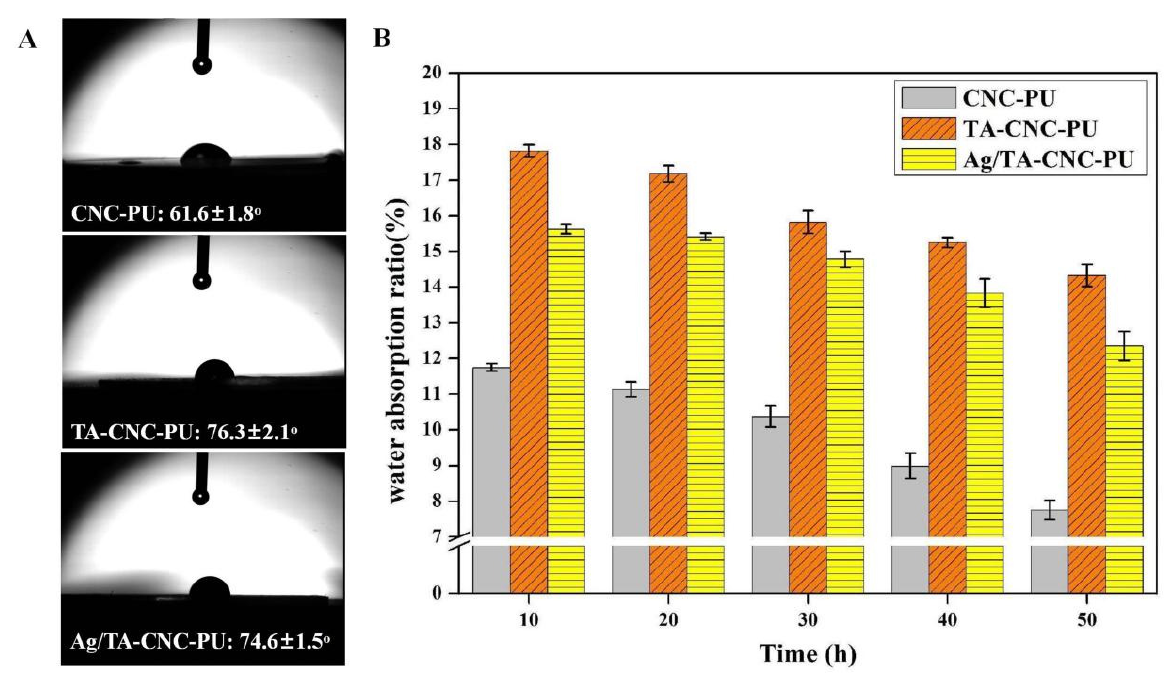
Figure 6. The hydrophilic properties of CNCs-based PUs. ( A ) Static water contact angle; ( B ) Water absorption ratio.